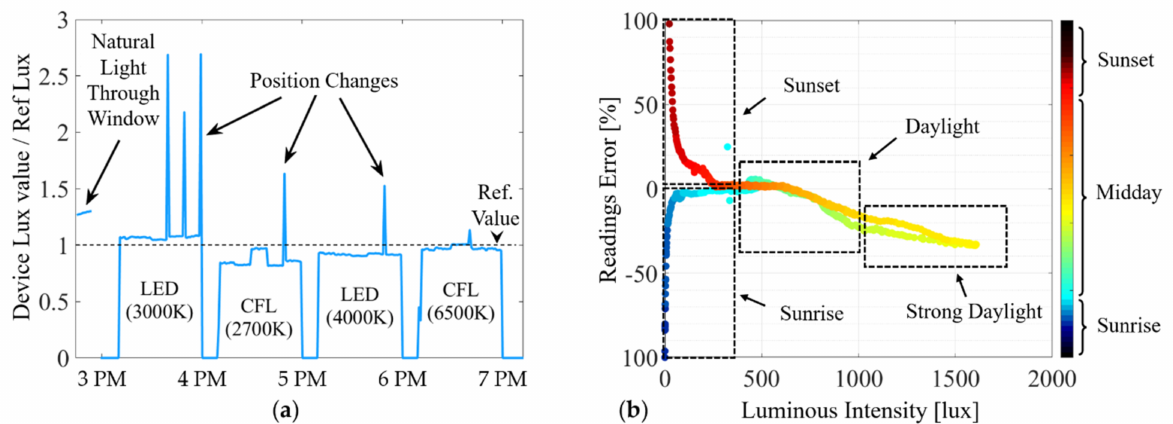
Figure 11. ( a ) Light intensity values given by the TSL2561 sensor in lux; values normalized to the lux value given by the spectrometer. Values from the sensor depend on the type of light source and its intensity and can induce errors. ( b ) Evolution of the low-cost system’s light intensity measurement error as a function of the spectrometer’s reference light intensity. Measurements made during a whole day in an environment mainly lit by natural light passing through a window. Selection of different natural light sources to add to the classification system for greater accuracy.